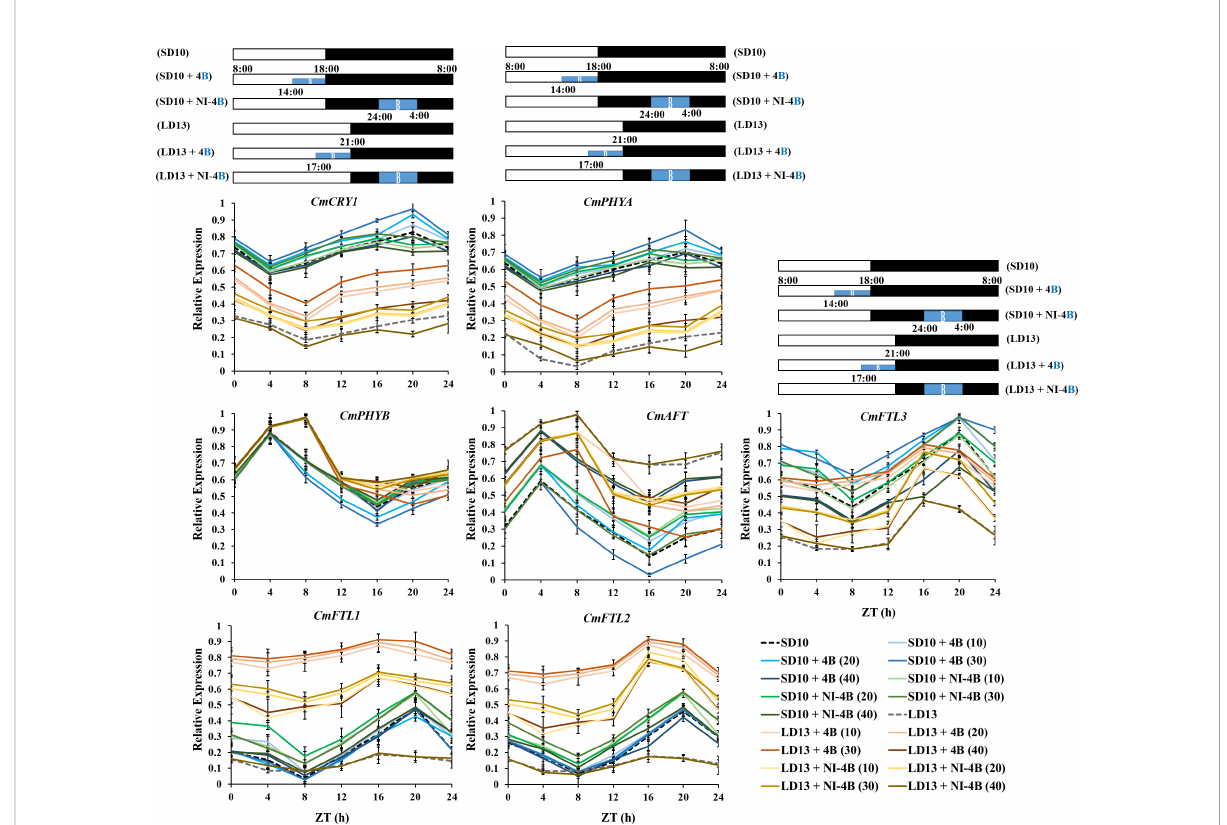
FIGURE 8 The temporal expression patterns of fl owering-related genes in leaves of chrysanthemum ‘ Gaya Glory ’ under different intensities of supplemental or night-interruptional blue light, after 7 days of exposure to the photoperiodic light treatments. For RNA extraction and RT-PCR, the top leaves (the fourth true leaves from the shoot apex) were harvested at 0, 4, 8, 12, 16, 20, and 24h after lights-on (from 8:00 a.m.), respectively (ZT 0, 4, 8, 12, 16, 20, and 24). The horizontal white and black bars represent the period of day and night, respectively; the blue bars represent the periods with different intensities of supplemental or night-interruptional blue light. Data were averagely normalized against the expression of CmACTIN and CmEF1 a . The maximum value in each experiment was set to “ 1 ” . Vertical bars indicate the means ± standard error of six biological replicates (n = 6), using RNA from separate plants. See Figure 1 for details of photoperiodic light treatments with blue